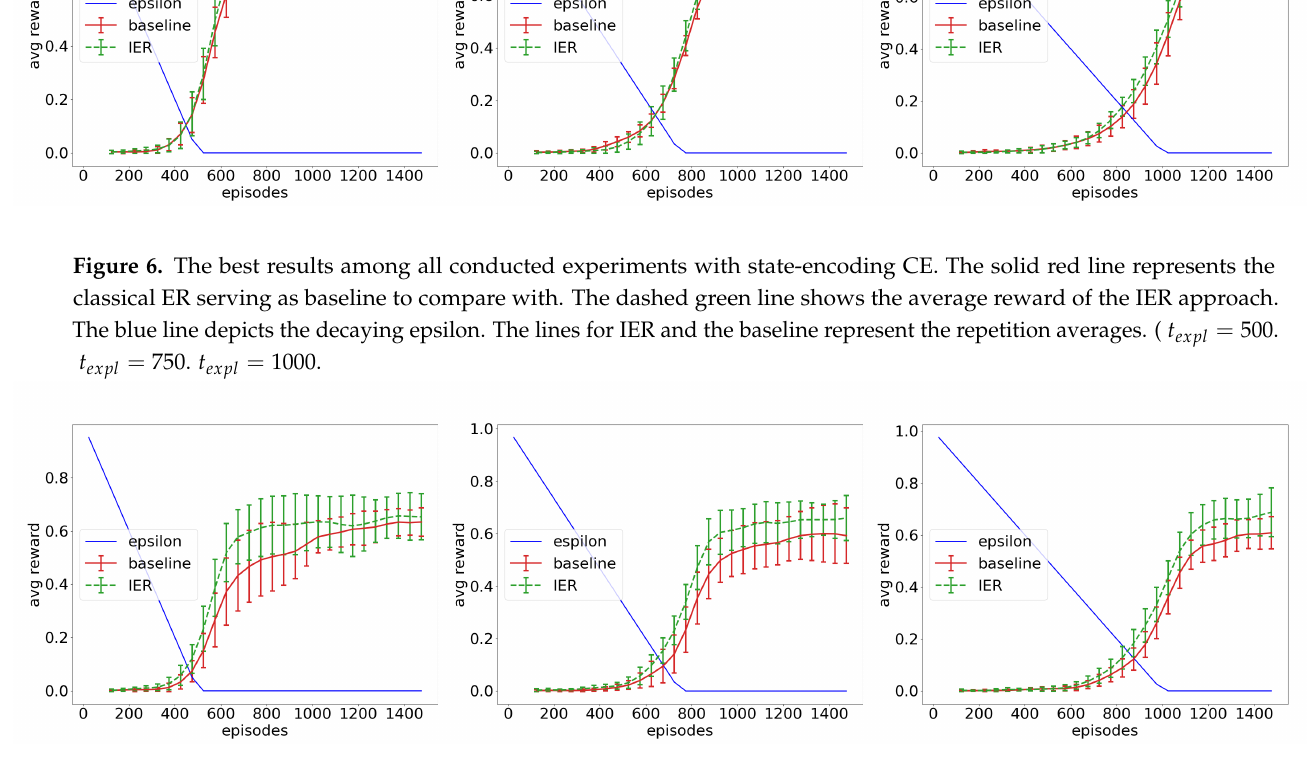
Figure 7. The best results among all conducted experiments with state-encoding LKE. The solid red line represents the classical ER serving as baseline to compare with. The dashed green line shows the average reward of the IER approach. The blue line depicts the decaying epsilon. The lines for IER and the baseline represent the repetition averages. t expl = 500. t expl = 750. t expl =